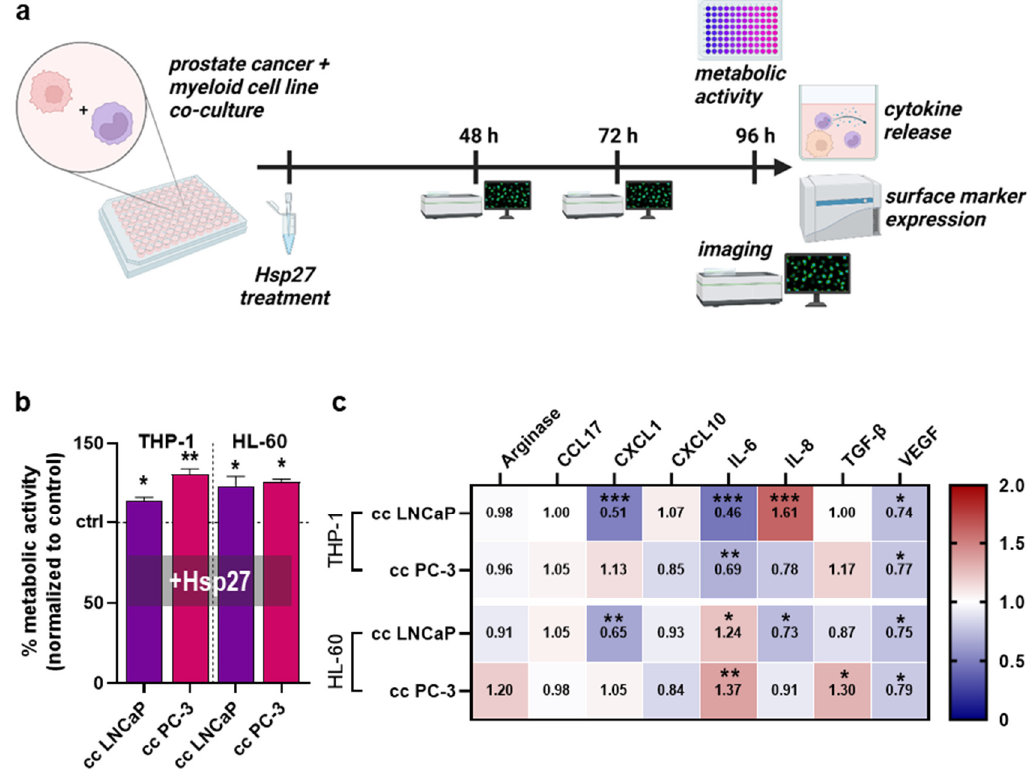
Figure 2. Co-culture metabolic activity and release profiles. ( a ) study protocol of the co-culture of prostate cancer cell lines with myeloid cell lines treated with Hsp27; ( b ) normalized metabolic activity of Hsp27 treated co-cultures; ( c ) normalized chemokine, cytokine, and growth-factor secretion profile 96 h after Hsp27 exposure in co-cultures. Data are representative of at least three experiments; statistical analysis was performed using one-way ANOVA ( b ) with p < 0.05 (*), p < 0.01 (**), and p < 0.001 (***).